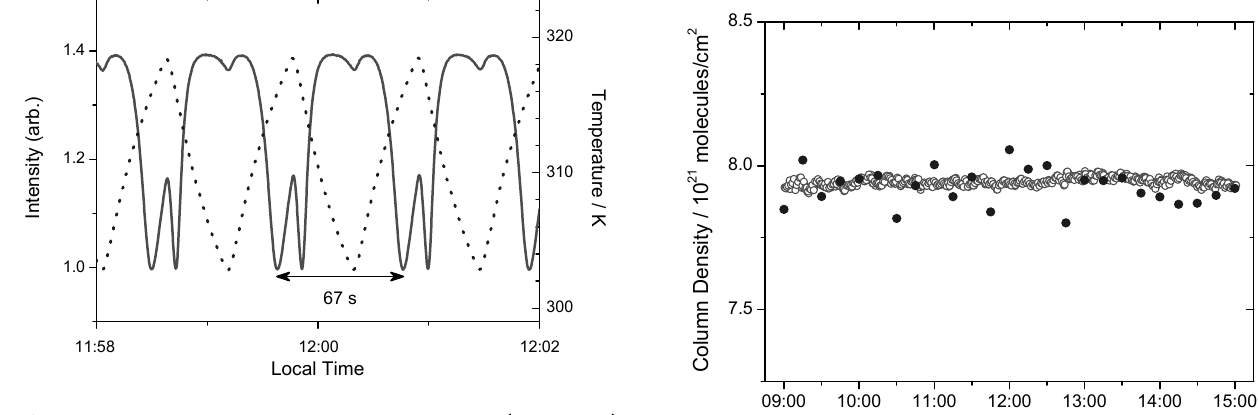
Fig. 11 Fig. 11. Signal intensity of the CO 2 photoabsorption (solid curve) measured by modulating the FFPI temperature in a 67s cycle (dot- ted curve). The highest value gives the I 0 while the lowest one corresponds to the I value in Eq. (1). Small dip at the top and hump at the bottom result from overshooting the etalon temperature.